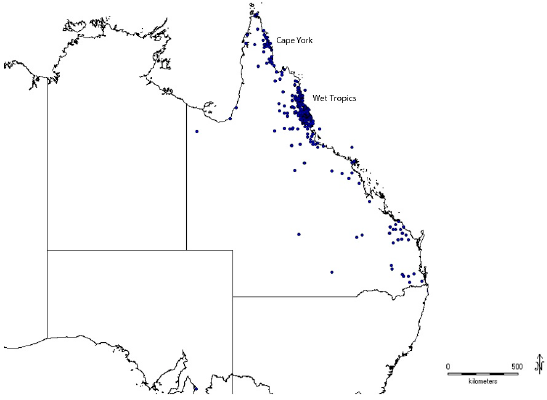
Figure 1. Distribution of BATF DNA barcode records across the state of Queensland, Australia.